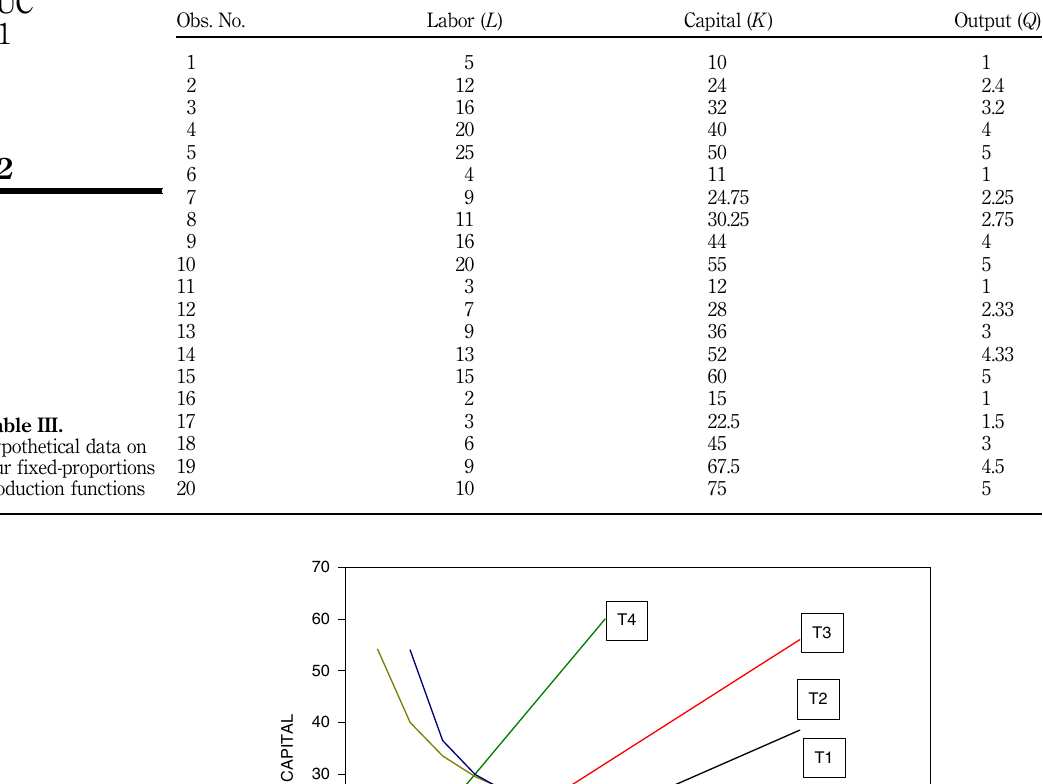
Figure 7. Fixed-proportions technologies and the estimation of Cobb – Douglas and CES production